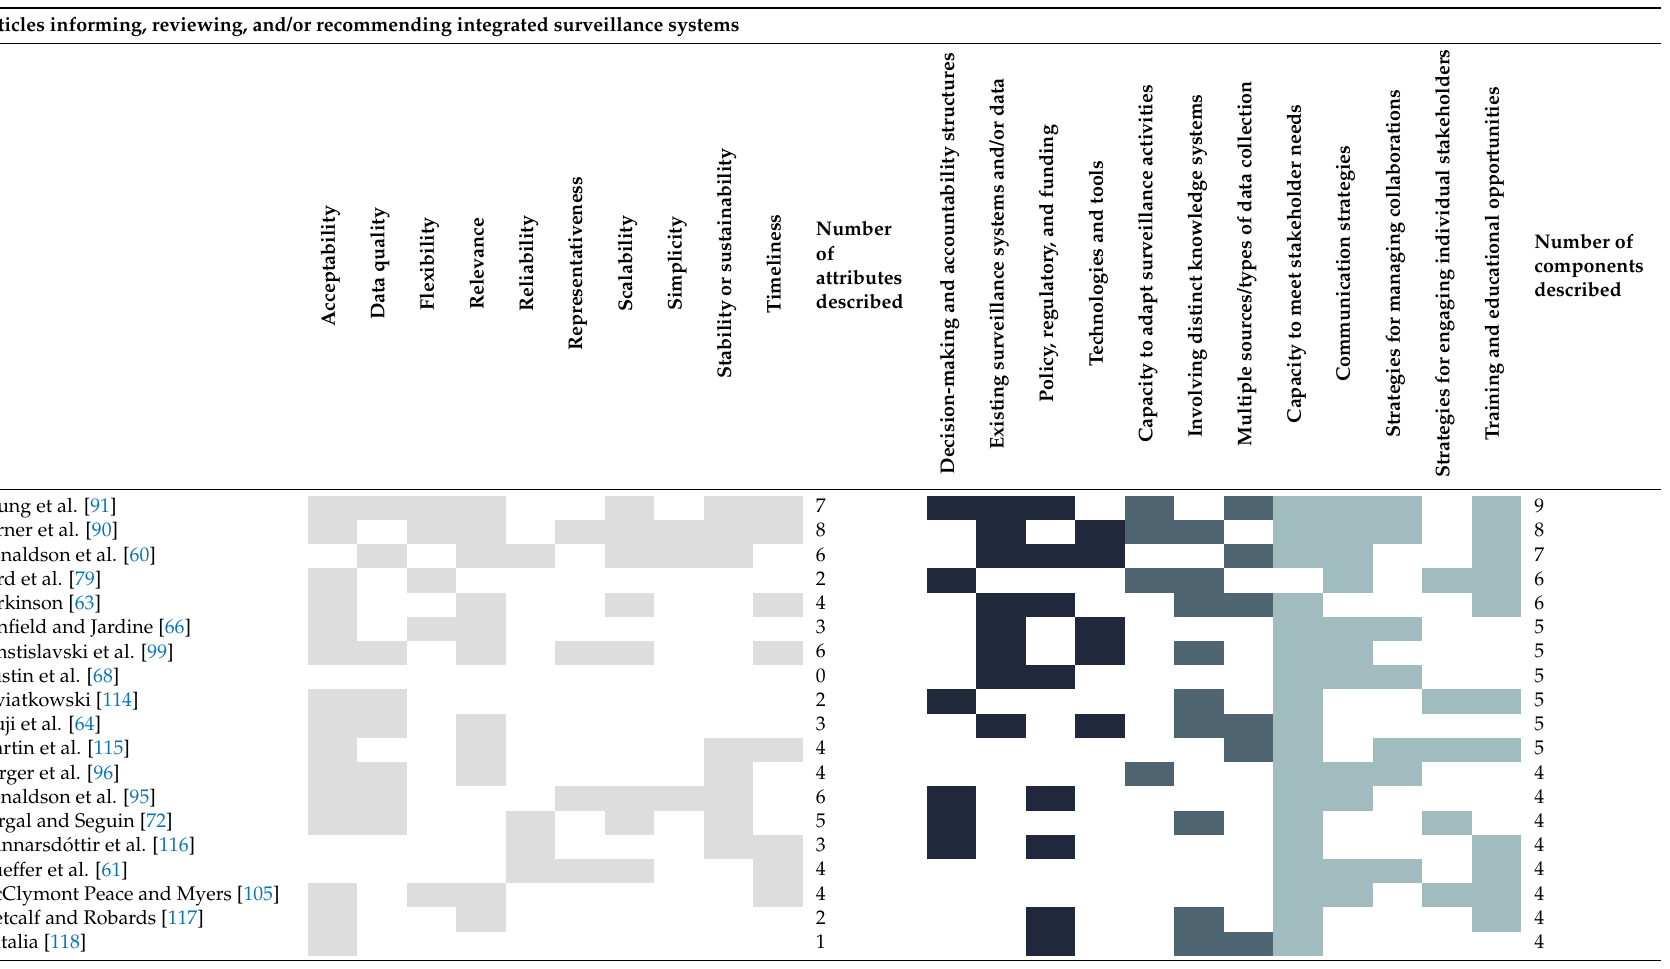
Table 3. Attributes and enabling components of integrated surveillance systems in Circumpolar Arctic and Subarctic regions as described in the literature, comprised of articles that informed, reviewed, and/or recommended integrated surveillance, and articles that described the development, implementation, and/or application of integrated surveillance. Articles are sorted in descending order, based on the number of components